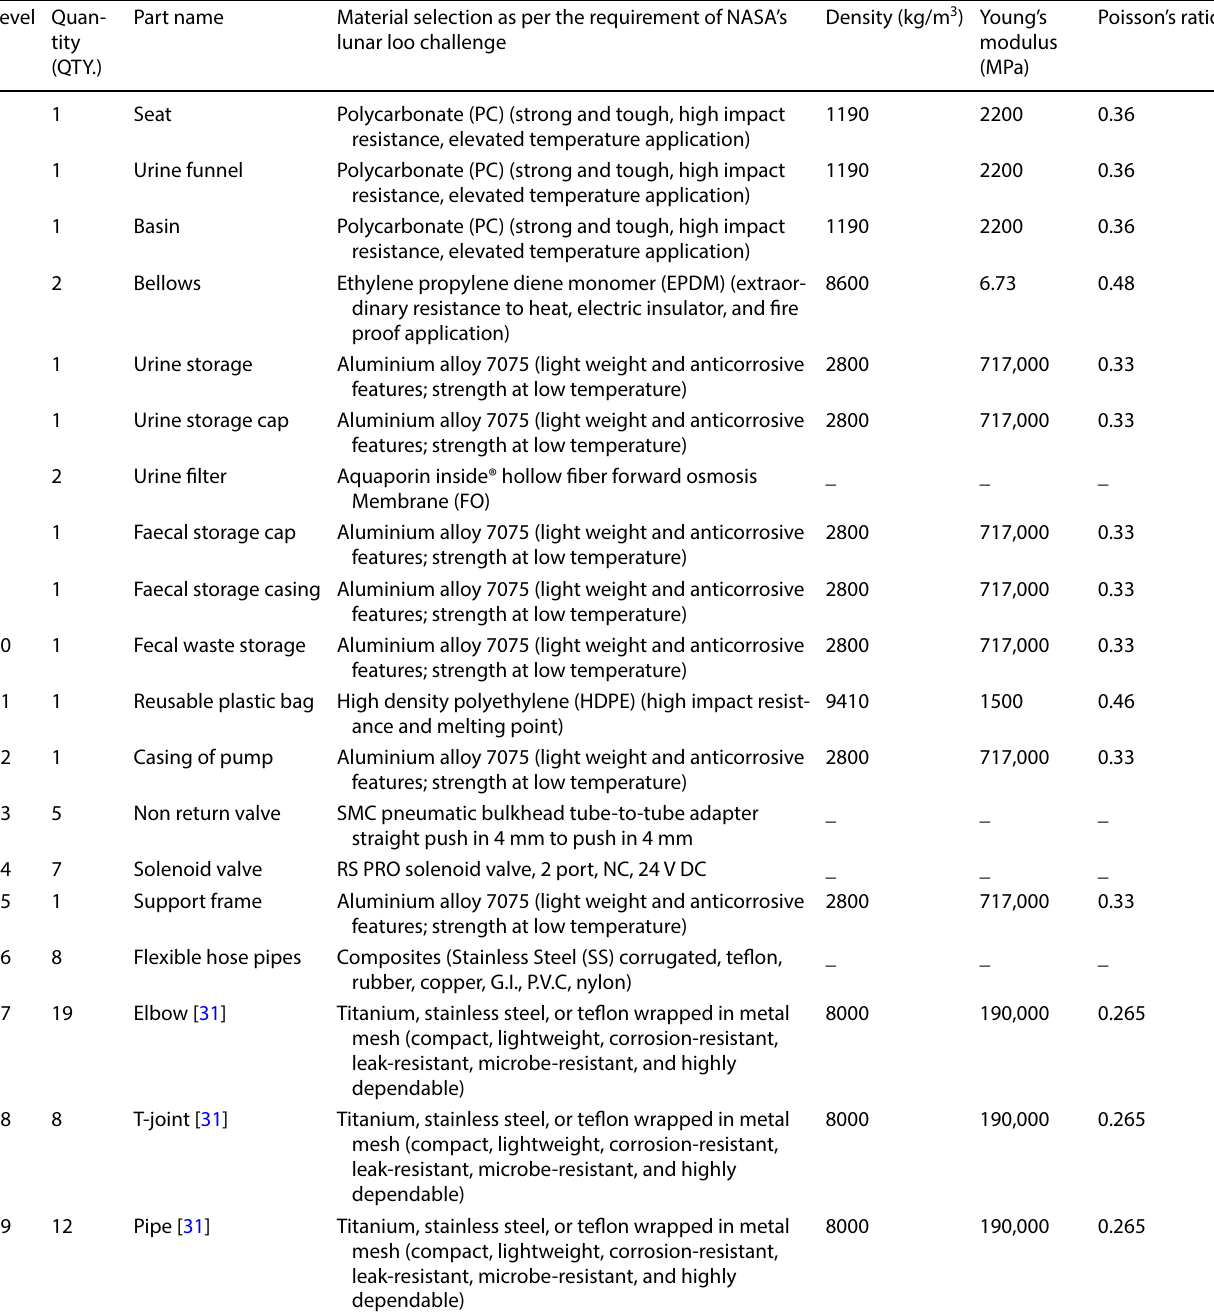
Table 3 Bill of materials: parts used in the numerical simulation of self-sustainable space toilets for any gravitational condition and inter- planetary missions Level Quan- tity